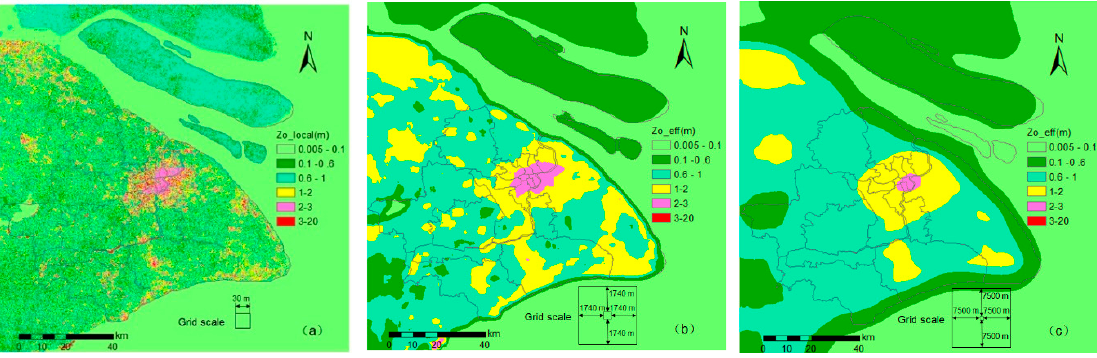
Figure4. Spatialvariation inShanghaibasedon ASTERGDEMV1(NASA / METI2009) data(resolution = Figure 4. Spatial variation in Shanghai based on ASTER GDEM V1 (NASA/METI 2009) data 30 m) of: ( a ) local roughness length ( z 0_local ) (Equation (1)); and e ff ective roughness length (Equation (7)) (resolution = 30 m) of: ( a ) local roughness length ( z 0_local ) (Equation (1)); and effective roughness length for ( b ) 70 m agl ( z 0_e ff ,70 ) averaged over 3480 m; ( c ) for 300 m agl ( z 0_e ff ,300 ) for 15,000 (Equation (7)) for ( b ) 70 m agl ( z 0_eff,70 ) averaged over 3480 m; ( c ) for 300 m agl ( z 0_eff,300 ) for 15,000 m.